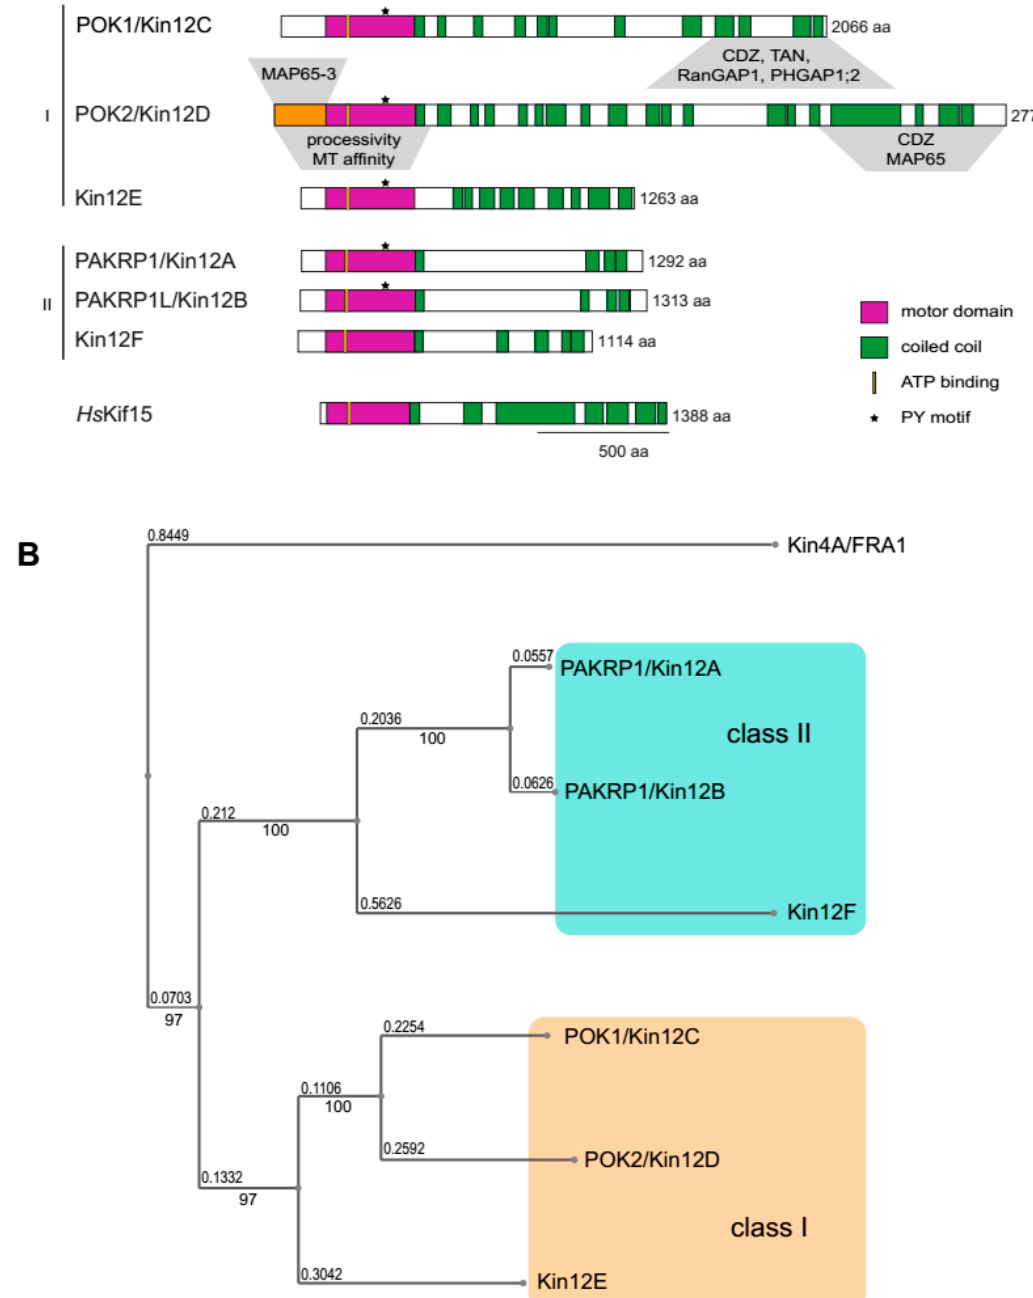
Figure 1. Protein domain architecture and phylogeny of Arabidopsis kinesin-12. ( A ) Arabidopsis kinesin-12 (Kin12A–F) are categorized in two classes: Class I includes the large PHRAGMOPLAST ORIENTING KINESINS 1 (POK1) / Kin12C and POK2 / Kin12D as well as the yet uncharacterized Kin12E; class II consists of PAKRP1 / Kin12A, PAKRP1L / Kin12B, and Kin12F. Kinesin-12 members have an N-terminal motor domain indicative of microtubule plus-end directed motility. Unlike the